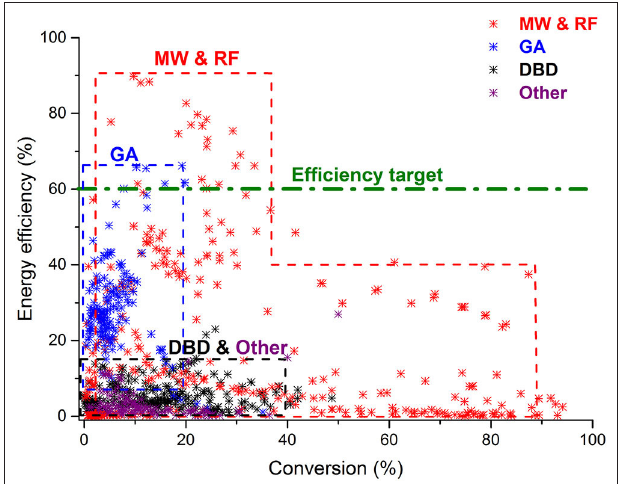
FIGURE 3 | Comparison of all data from literature for DRM in different plasma reactors, illustrating the energy cost as a function of conversion. The target energy cost of 4.27 eV/molec for syngas production (corresponding to 60% efficiency target) is also indicated. The y-axis is reversed to allow easier comparison with Figure 2 . Adopted from Snoeckx and Bogaerts (2017) with